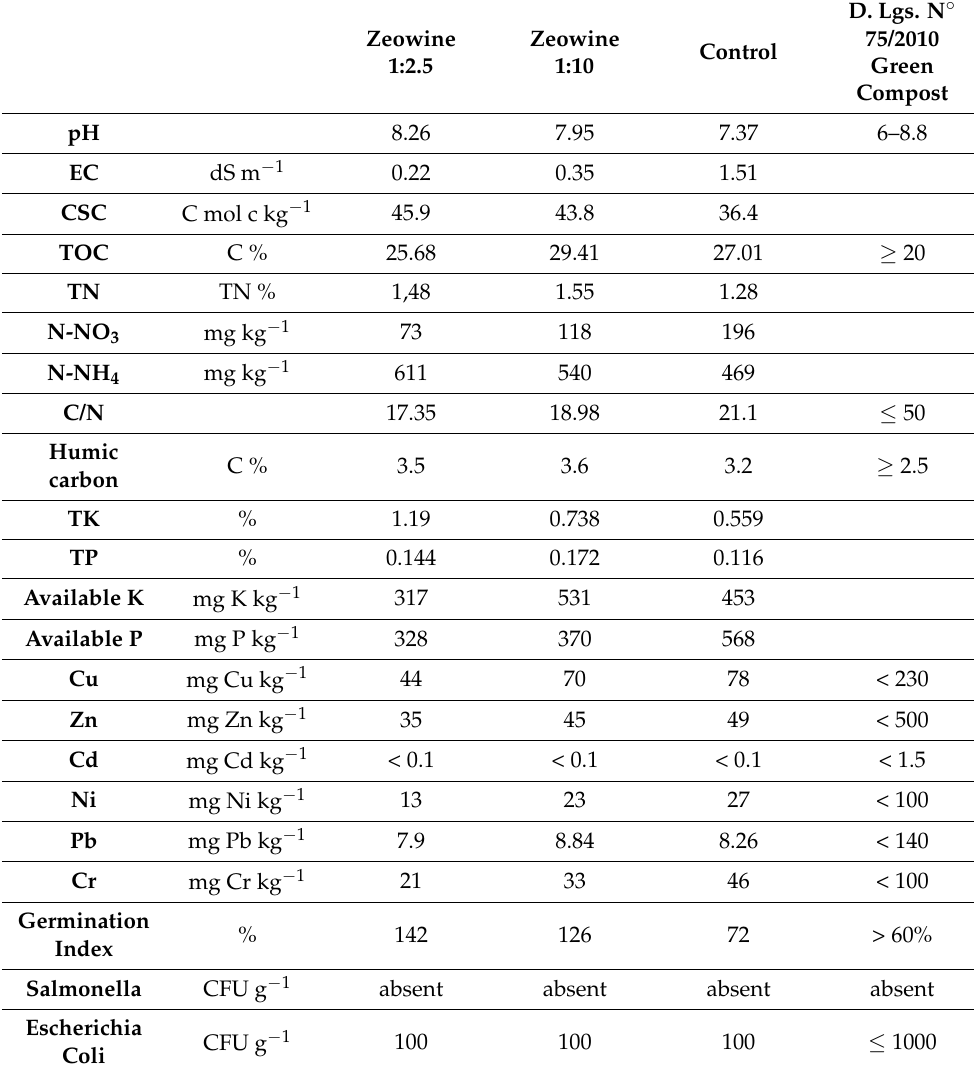
Table 3. Zeowine traits. The analyses were carried out by the CNR-IRET—National Research Council-Research Institute on Terrestrial Ecosystems (PI),